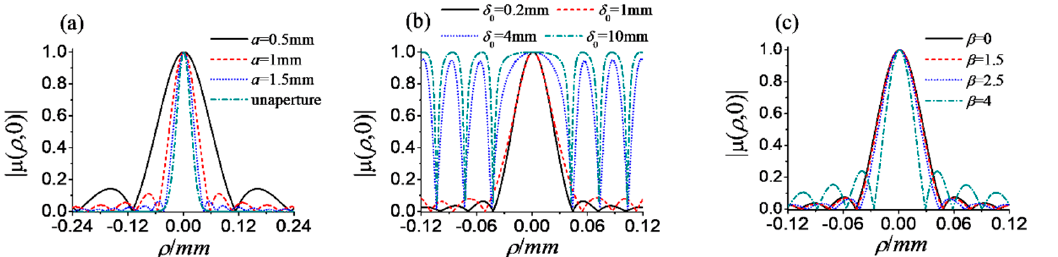
Figure 6. Dependence of modulus of the SDOC | μ ( ρ ,0)| of apertured BGCSM beams in the focal plane on ( a ) the normalized truncation parameter a , ( b ) the transverse coherence width δ 0 , and ( c ) the parameter β . The other parameters were set as δ 0 = 0.2 mm and β = 2.5 in ( a ), a = 1.5 mm and β = 2.5 in ( b ), and a = 1.5 mm and δ 0 = 0.2 mm in ( c ).